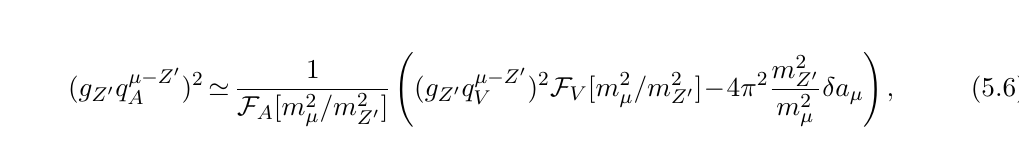
as a function of g Figure 1 . g Z 0 q µ − Z 0 A δa µ = 2 . 5 × 10 − 9 (1.3) and dashed lines have δa µ = 0 for m Z 0 = 1 , 20 , 100